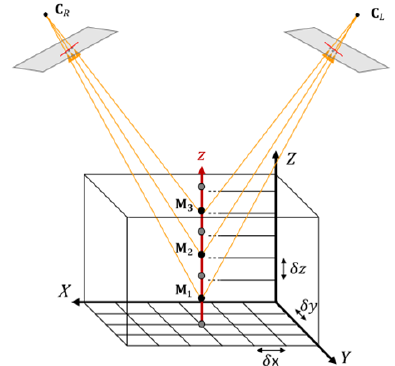
Figure 2: Inverse triangulation. Three different 3D points are tested for a specific XY coordinate in the regular grid. The cube represents the measurement volume with resolutions 𝛿 𝑥 , 𝛿 𝑦 and 𝛿 𝑧 (Buschinelli et al. ,